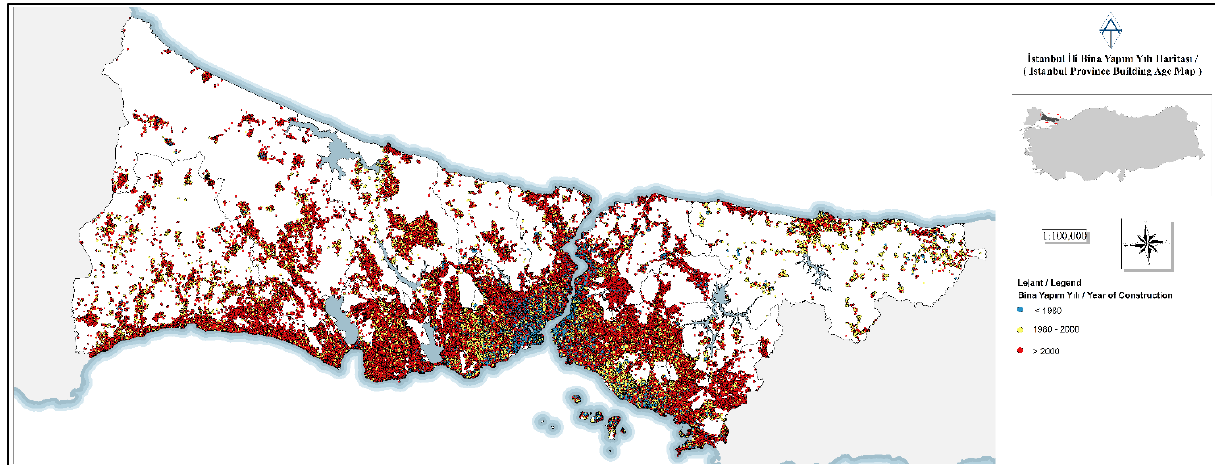
Figure 18. Istanbul Province Building Age Map.